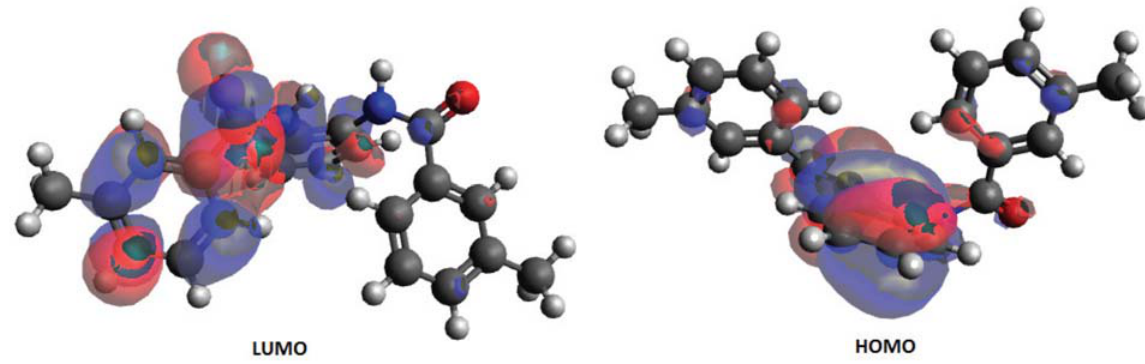
Figure 7. The atomic orbitals compositions of the frontier molecular orbital for compound I .